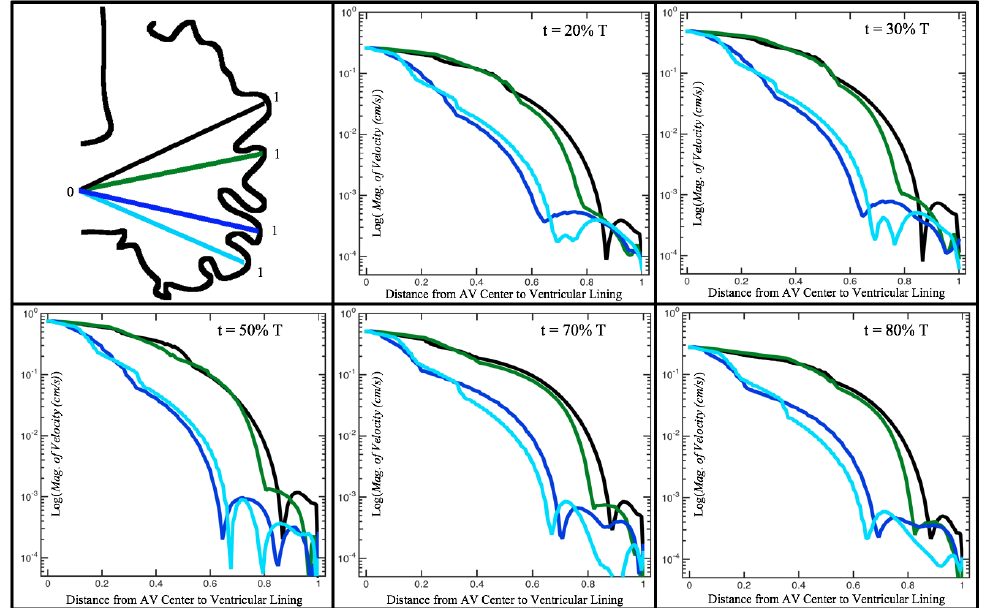
Figure 11. Plots showing how the log magnitude of velocity decays from the center of the AV canal to the ventricle wall for four different lines across the chamber using a 5 dpf WT (I) embryo’s geometry at Re = 1. The velocity decays until it reaches a trabeculae height away from the ventricle wall. Within pronounced trabecular valleys, the velocity increases before decaying further when measured closer to the ventricular lining. Each sub-figure corresponds to a different time during the pulsation cycle, described by a percentage of the pulsation period, T